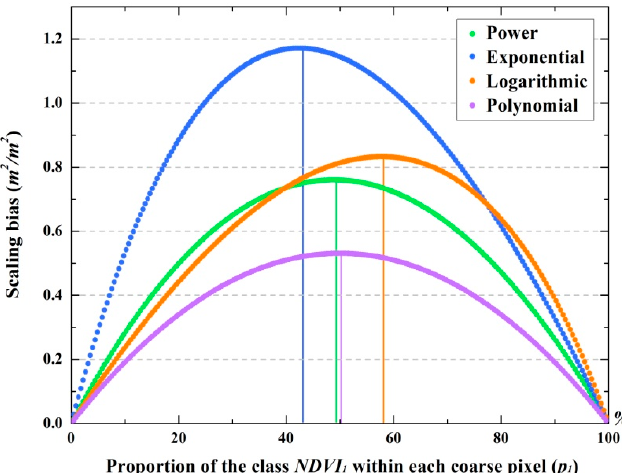
Figure 7. The relationship between scaling bias and the proportion of class ( NDVI 1 ) within coarse pixels for four types of LAI estimation models.